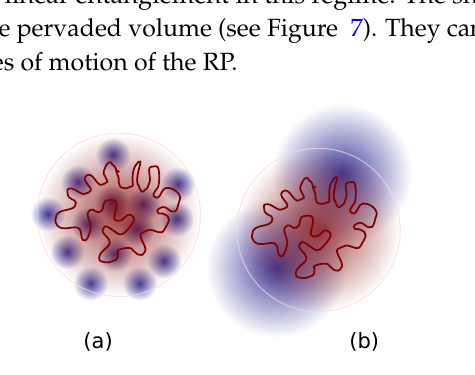
Figure 7. Schematic of infiltration of a ring probe by matrix LPs of ( a ) low; and ( b ) high, molar mass N l